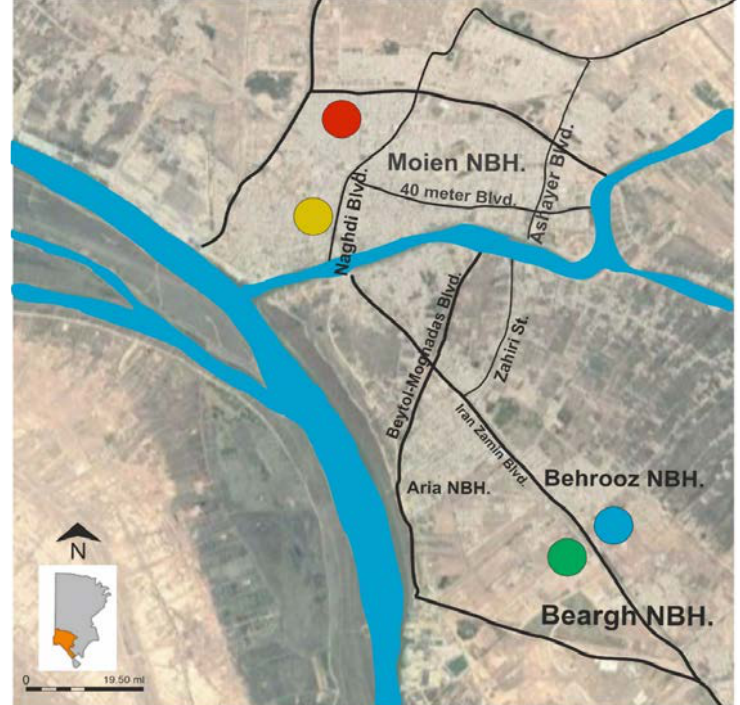
Fig. 2: Location of urban morphotypes in Khoramshahr